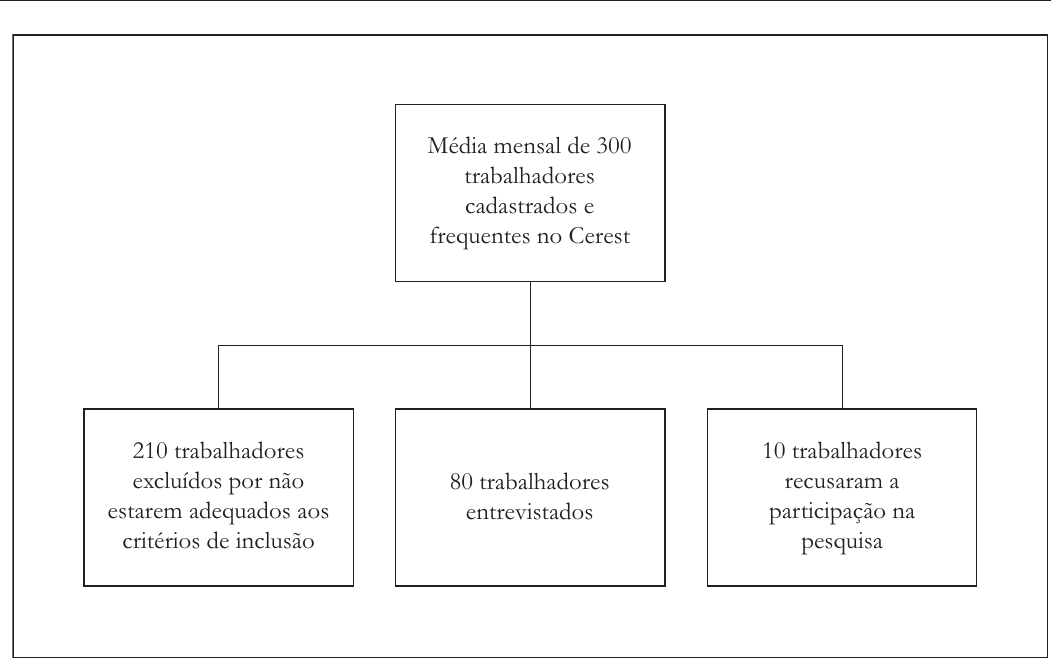
Figura 1 - Organograma representativo da seleção dos sujeitos da